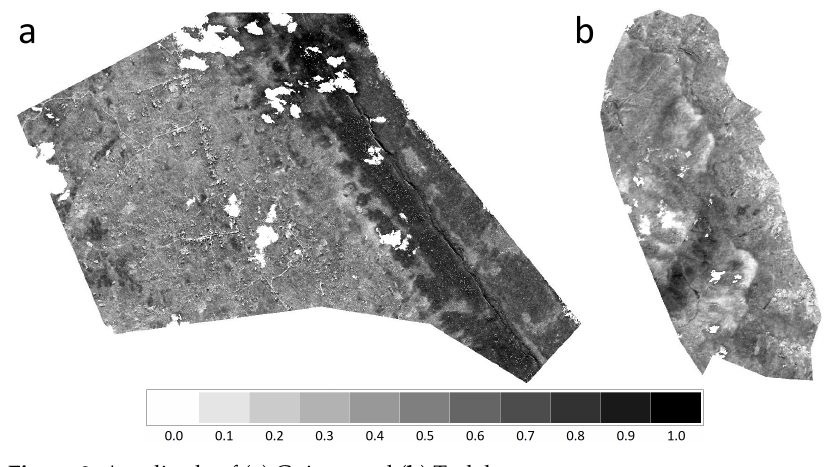
Figure 9. Amplitude of ( a ) Guiuan and ( b ) Tacloban.